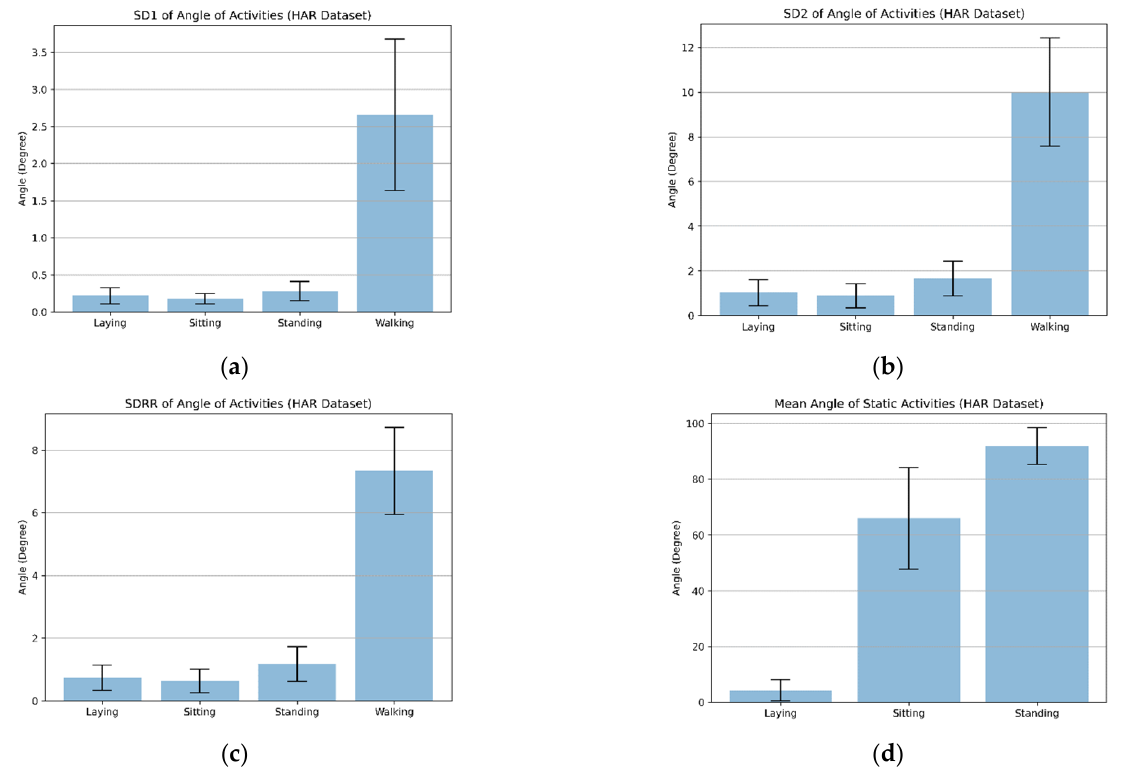
Figure 7. ( a – c ) Bar plot of SD1, SD2, and SDRR, respectively, for laying, sitting, standing, and walking. ( d ) Bar plot of the mean angle for static activities with the HAR dataset.